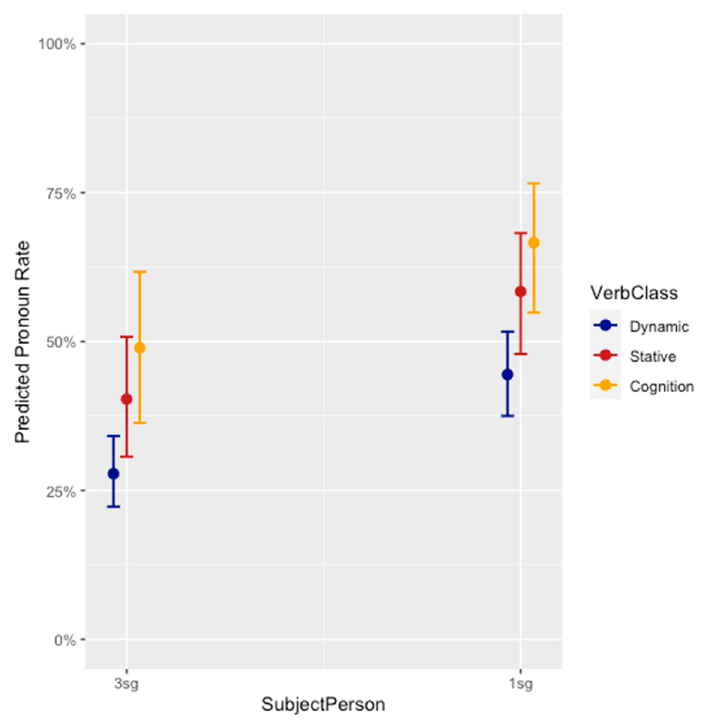
Figure 1. Predicted rate of subject expression for subject person by verb class, from model presented in Table 1. Pronominal subjects are favored most with 1sg vs. 3sg subjects and with cognition verbs.